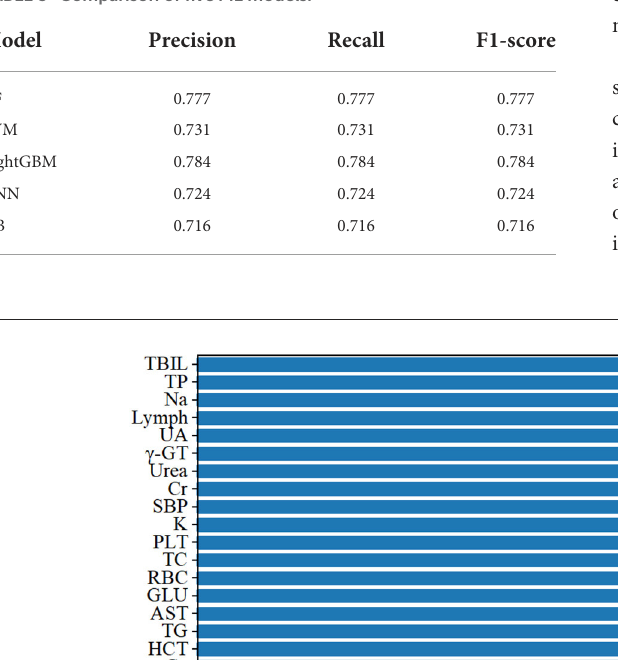
TABLE 3 Comparison of five ML models.